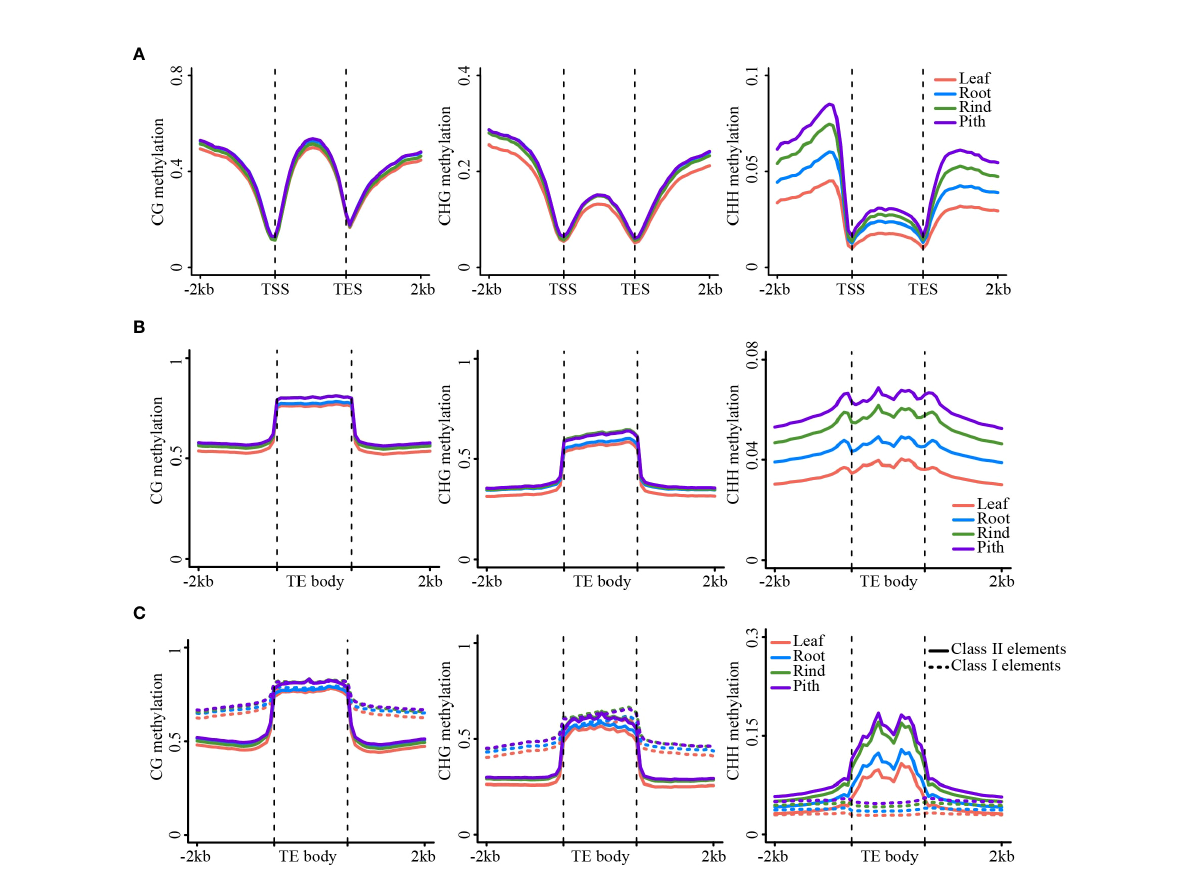
FIGURE 2 DNA methylation patterns in gene/TE and fl anking regions. (A) The metaplot of the gene body and the fl anking region. (B) The metaplot of TE and the fl anking region. (C) The metaplot of the Class II TE and Class I TE. CG (left), CHG (middle), CHH